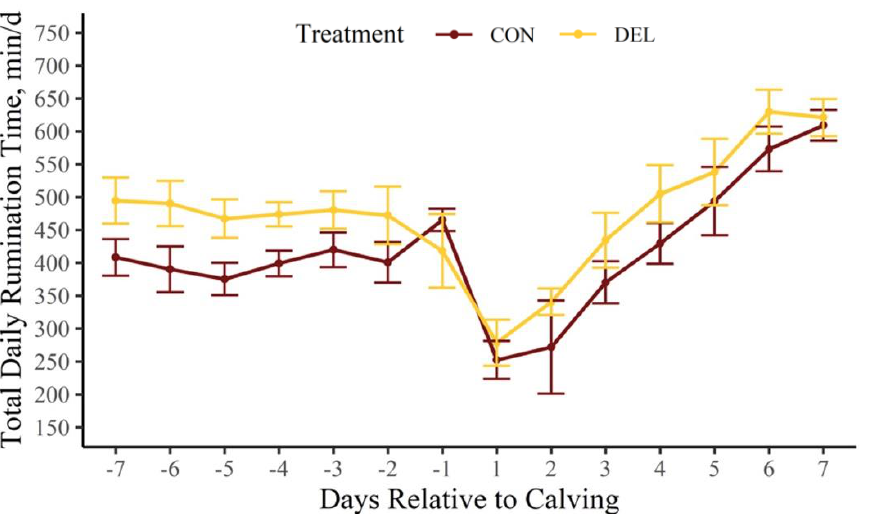
Figure 2. Total daily rumination time (RT, min/d) in multiparous cows administered oral Ca boluses. Two Ca boluses were administered simultaneously within 24 h (CON) or between 24 and 48 h (DEL) of calving. Least square means (±SEM) from − 7 to +7 days in milk (DIM) are reported for 6 CON and 8 DEL cows. The first hour of day 1 coincides with the time of reported calving. Effect of DIM on total Daily RT differed among days ( p < 0.001) but was not affected by treatment ( p = 0.07) or the interaction of treatment by day ( p = 0.65).